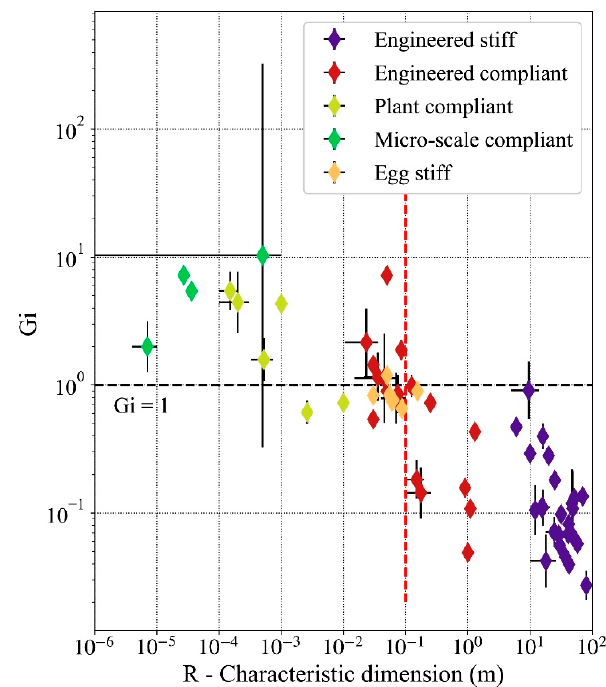
Figure 4. Gravitational force density impact in thin shells as a function of the characteristic dimension. The scale for both axes is logarithmic. The horizontal dotted line indicates values G i = 1 for which the gravitational force becomes predominant in the equilibrium of the shell. The red dotted line at R = 0.1 m represent the approximate limit at which thin shells start to be constrained by gravity.